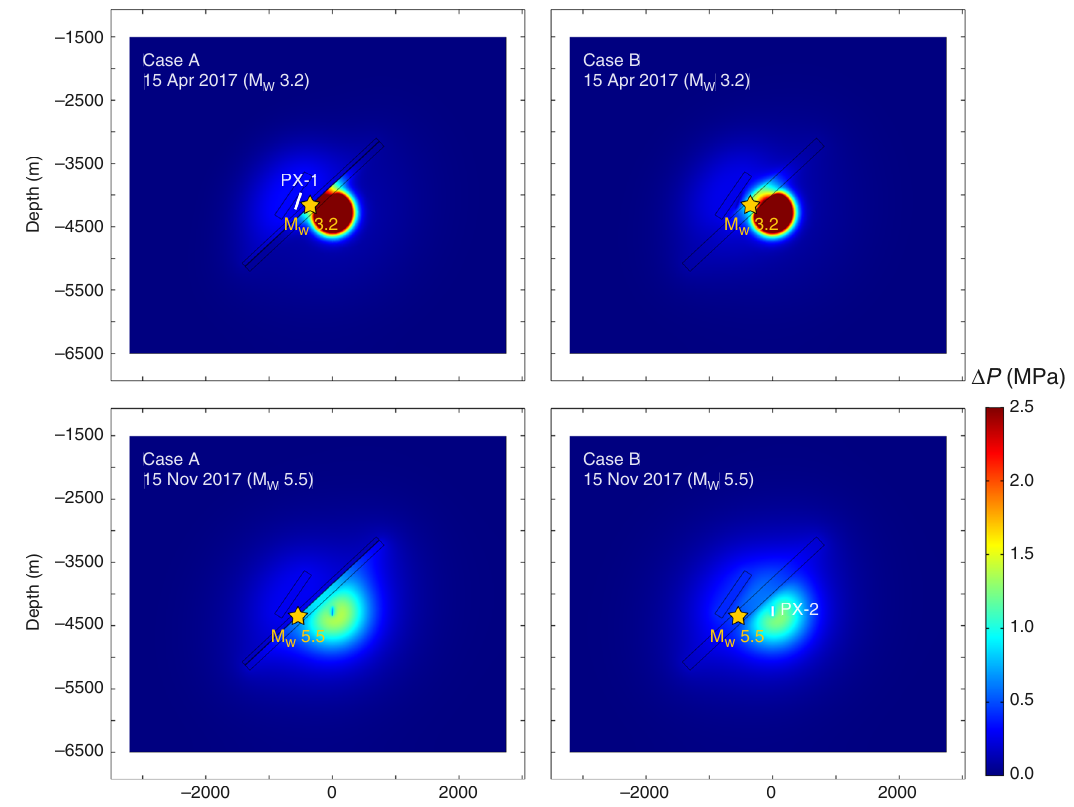
Fig. 5 Modeled pore pressure change. The pore pressure change (MPa) is shown in vertical cross-section (location shown in inset in Fig. 4b) through PX-1 and PX-2 on April 15, 2017 (upper row) and November 15, 2017 (lower row) when the M w 3.2 and the M w 5.5 earthquakes occurred, respectively. Left and right columns correspond to Cases A (core hydraulic diffusivity D = 1.0 × 10 − 6 m 2 s − 1 and damage zone D = 0.1 m 2 s − 1 , small fault D = 1.0 m 2 s − 1 ) and Case B (same as Case A except without a fault